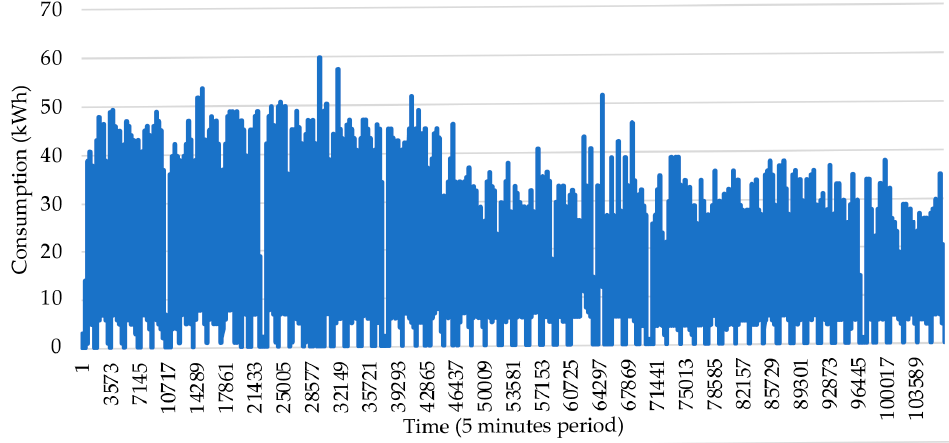
Figure 3. Consumption raw data from 1 January 2018 to 26 September 2019.